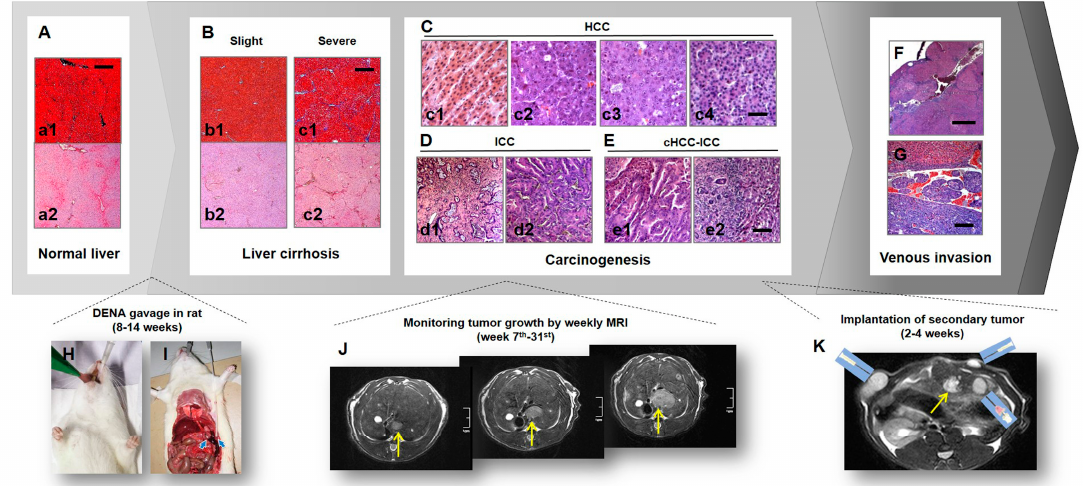
Figure 1. Rodent models of primary and secondary liver tumors mimicking human liver cancers. ( A , B ): histopathology of normal ( A ) and cirrhotic ( B ) livers (a1, b1, c1: Masson’s trichrome staining; a2, b2, c2: CD34-PAS red staining; × 100 original magnification, scale bar = 200 µ m). ( C ): H&E staining of hepatocellular carcinoma (HCC) ( × 200 original magnification, scale bar = 25 µ m). ( D ): H&E staining of intrahepatic cholangiocarcinoma (ICC) ( × 200 original magnification, scale bar = 50 µ m). ( E ): H&E staining of cHCC-ICC ( × 200 original magnification, scale bar = 50 µ m). ( F ): Evidence of hepatic HCC invading portal veins (H&E staining; × 50 original magnification, scale bar = 500 µ m). ( G ): Tumor emboli present in hepatic vein (H&E staining; × 100 original magnification, scale bar = 100 µ m). ( H ): Daily gavage of DENA in rats. ( I ): Customized plastic needle catheter precisely passing rat cardia,